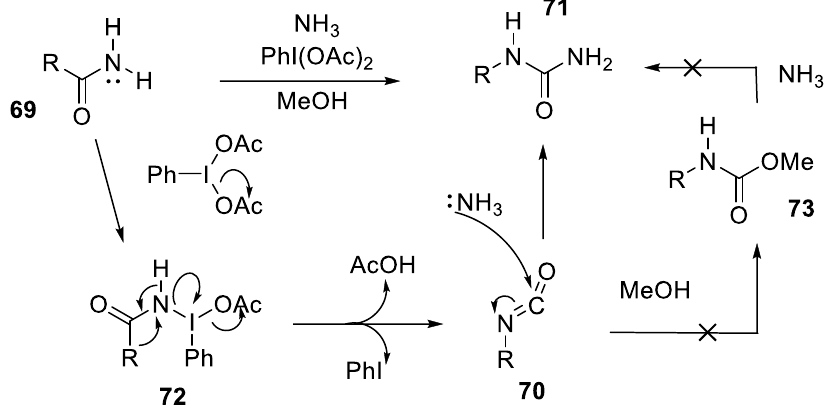
Figure 11. Proposed mechanism for PIDA-mediated Hofmann rearrangement.